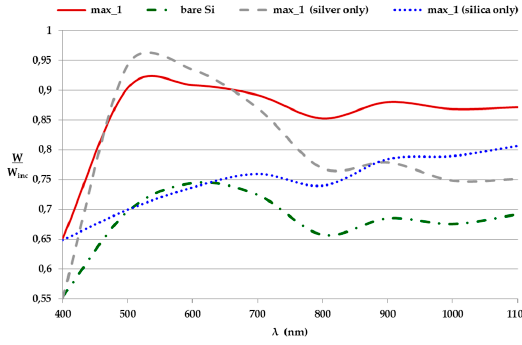
Figure 4. Efficiency of the optimized cell (max_1).